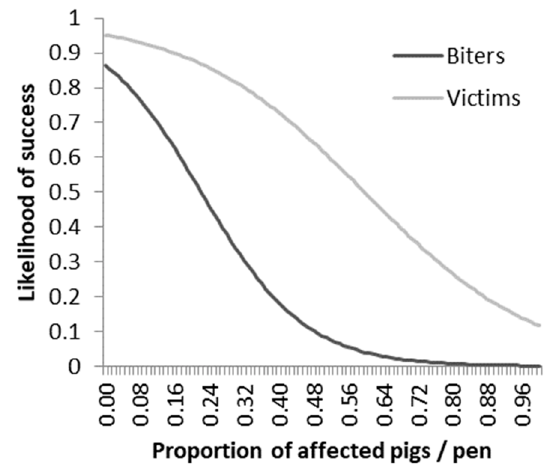
Figure 4. Probability of a successful intervention based on the proportion of biters and victims identified during the course of an outbreak in the pen. The curves are plotted using the intercepts and betas extracted from the logarithmic model of the data.